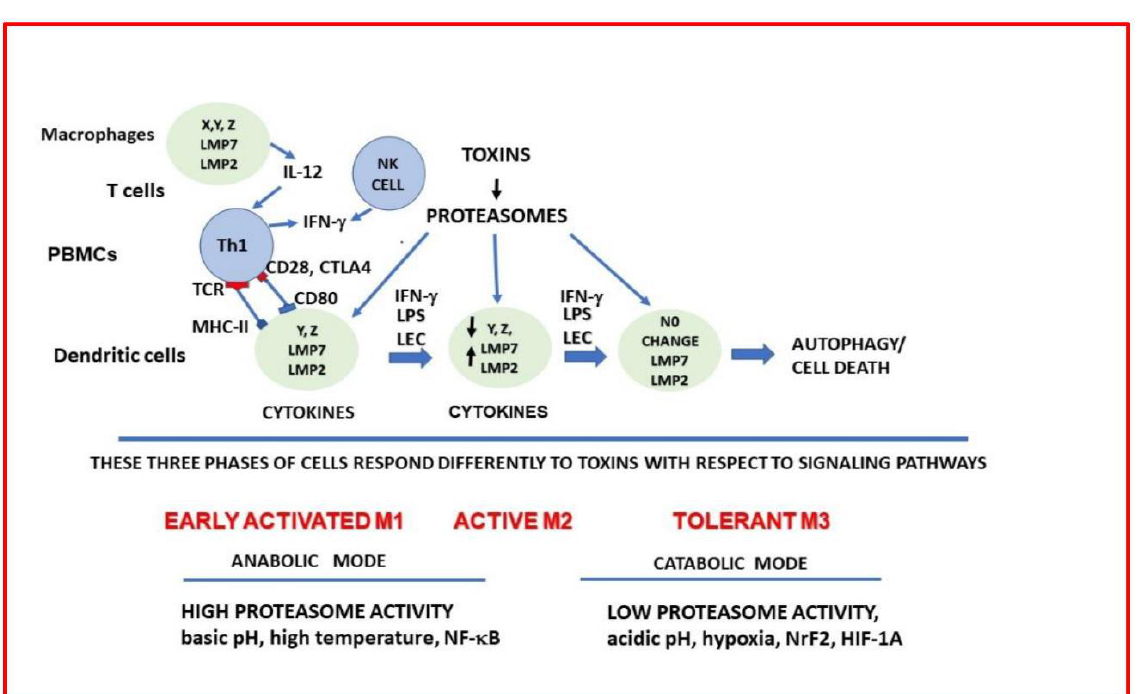
Figure 6. Summary of the effects of proteasome modulators on the immune system. LPS and LEC upregulates expression of several genes. RES either has no effect, downregulates, or upregulates expression of genes.